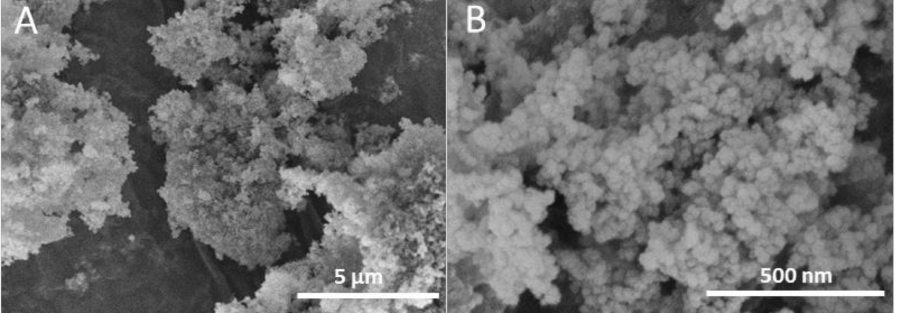
Figure 3. Field emission scanning electron microscope (FE-SEM) images of the as-received hydropho- bic silica at two different magnifications ( A , B